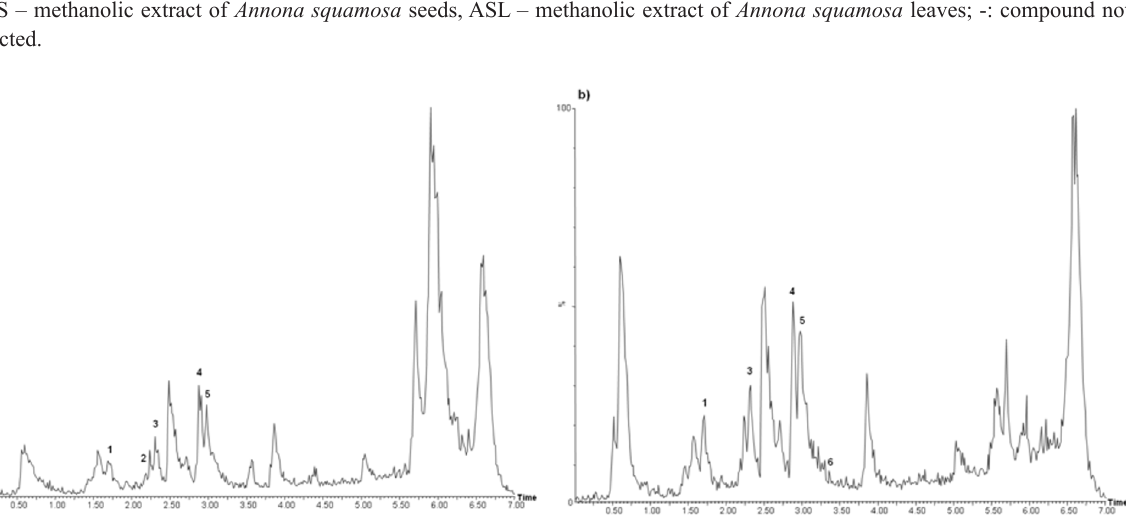
Figure 1 - Chromatograph of the methanolic extracts from Annona squamosa ( a ) seeds (ASS) and ( b ) leaves (ASL) analyzed by UPLC-ESI-MS/MS. The assignments for identified compounds (time of retention and MS/MS spectra) are based on comparisons with the corresponding isolated standards. (1) reticuline, (2) corypalmine, (3) asimilobine, (4) nornuciferine, (5) anonaine, (6)